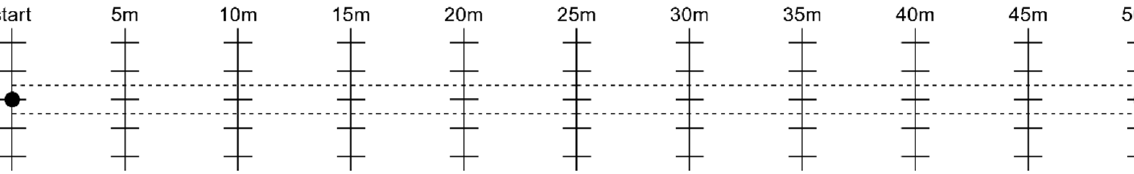
Figure 3. The general set-up of the straight-line walking task is depicted. The field was 50 m long and 6 m wide. The dotted lines indicate the ideal walking corridor. Deviations from this walking lane were documented every 5 m. If the subjects diverged more than 3 m from the ideal straight heading, the trial was aborted.